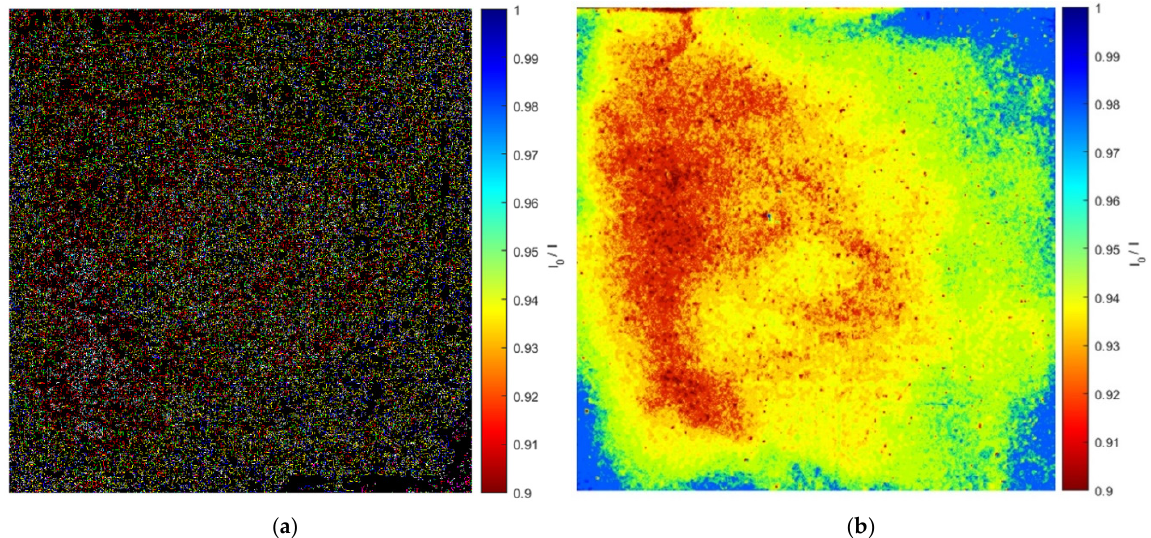
Figure 5. Data processing of wind-off and wind-on images: ( a ) processed with MATLAB R2018b software; ( b ) enhanced MATLAB